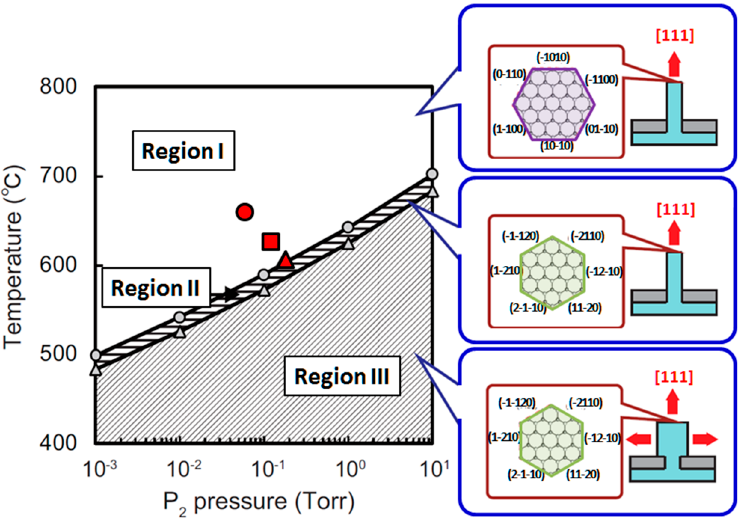
Figure 35. Phase diagram for growth modes of InP NWs as functions of temperature and pressure. Red circle, square, and triangle represent the experimental growth conditions for the high temperature and low V/III ratio, the intermediate temperature and V/III ratio, and the low temperature and high V/III ratio, respectively [90,91].